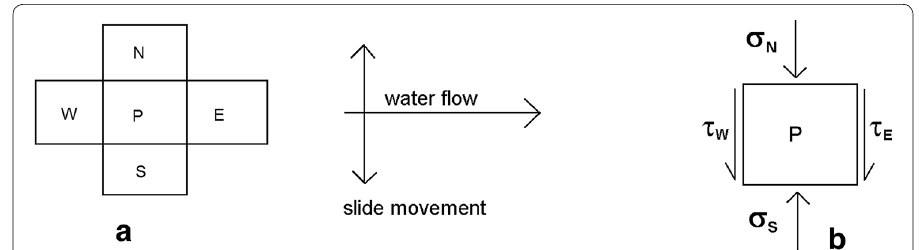
Fig. 5 a Computational molecule for cell P and the four neighbours, S, W, N and E. b Normal (σ) and shear (τ) stresses on the sides of cell